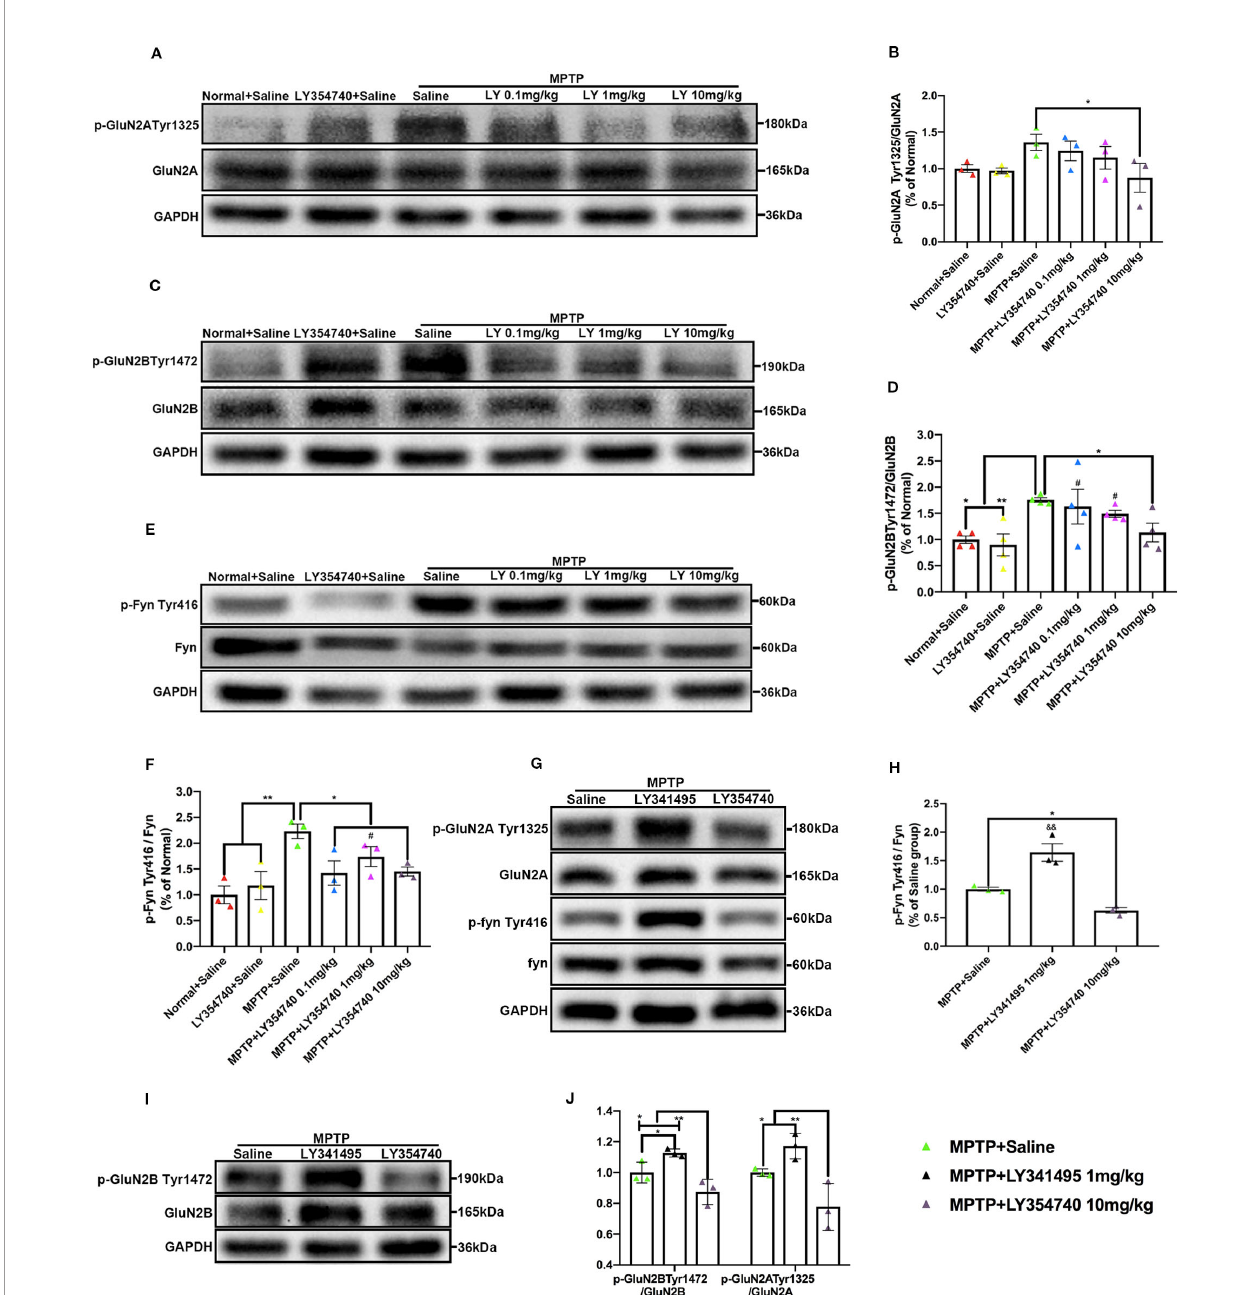
FIGURE 4 | Ligands of mGlu 2/3 receptors in fl uence expression of phosphorylated Fyn and subunits of N-methyl-D-aspartate receptors (NMDAR) in substantia nigra (SN) in sub-acute 1-methyl-4-phenyl-1,2,3,6-tetrahydropyridine (MPTP)-treated mice. Western blot analysis showed the levels of p-GluN2A tyr1325 (A) , p-GluN2B Tyr1472 (C) and p-Fyn Tyr416 (E) in SN of each group. Quanti fi cation of ratios of p-GluN2A tyr1325/GluN2A (B) , p-GluN2B Tyr1472/GluN2B (D) . *p < 0.05, **p < 0.01; # p < 0.05 vs. LY354740 + saline group. N = 3 per group in (B) ; N = 4 per group in (D) . Quanti fi cation of the ratio of p-Fyn Tyr416/Fyn (F) of each group. *p < 0.05, **p < 0.01; # p < 0.05 vs. the normal + saline group. N = 3. Relative band intensities were calculated as a ratio of the phosphorylated protein to total protein. The data above were expressed as % of the normal + saline group and error bars represent SEM. Western blot analysis showed the levels of p-GluN2A tyr1325, p-Fyn Tyr416 (G) and p-GluN2B Tyr1472 (I) in SN of each group. (J) Quanti fi cation of ratios of p-GluN2A tyr1325/GluN2A and p-GluN2B Tyr1472/GluN2B of each group. *p < 0.05, **p < 0.01. N = 3. (H) Quanti fi cation of ratios of p-Fyn Tyr416/Fyn of each group. *p < 0.05; && p < 0.01 vs. the other two groups. N = 3. Relative band intensities were calculated as a ratio of the phosphorylated protein to total protein. Data in (H, J) were expressed as % of the saline group and error bars represent